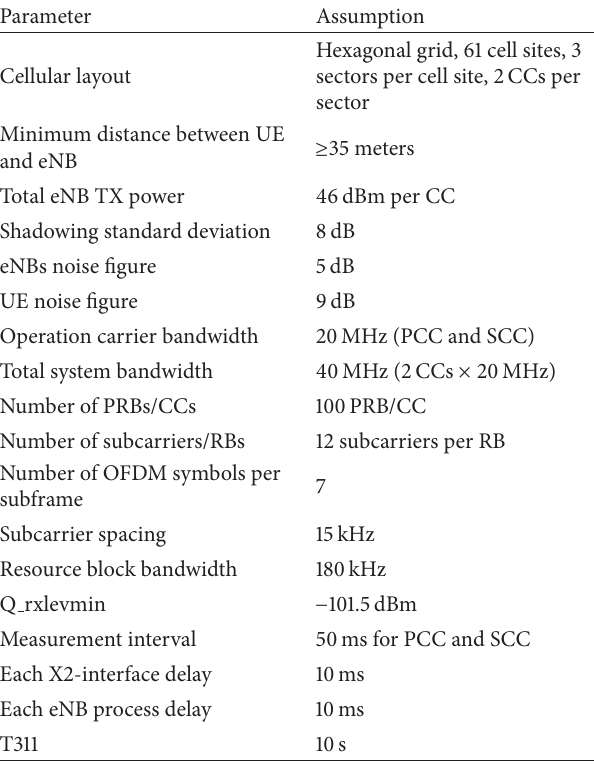
Table 1: Simulation parameters